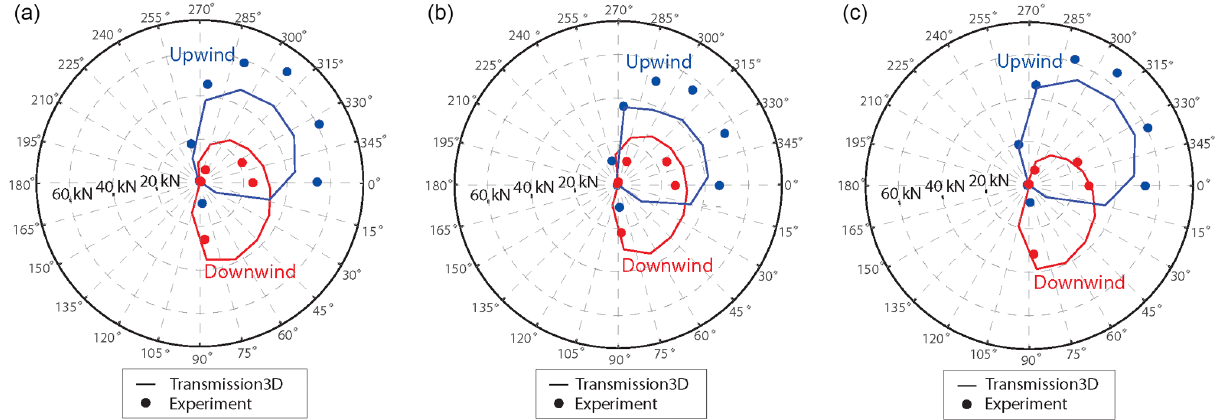
Figure 5. Planet CRB load zones with − 300kNm (a) , pure torque (b) , and + 300kNm (c) pitch